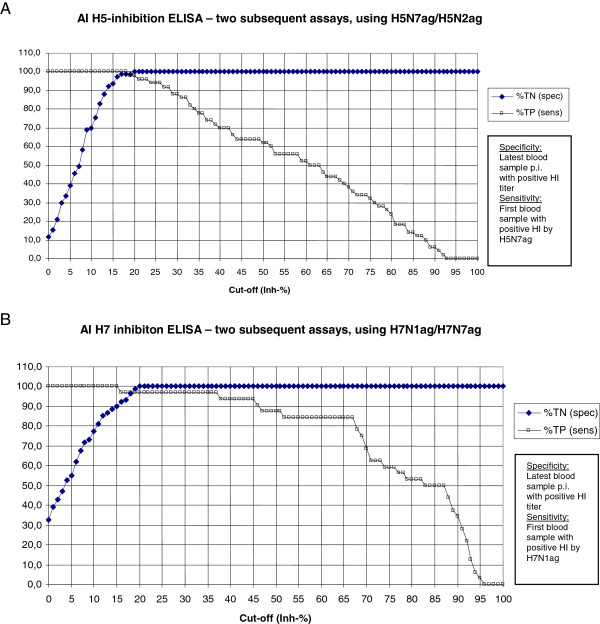
ROC curves for inhibition ELISAs. A) H5 ELISA and B) H7 ELISA. The lowest of the inhibition% (inh-%) given by each successive ELISA using H5N7ag/H5N2ag for H5, H7N1ag/H7N7ag for H7, is taken into account, Sens: sensitivity, spec: specificity, their percentage is shown in y-axis.